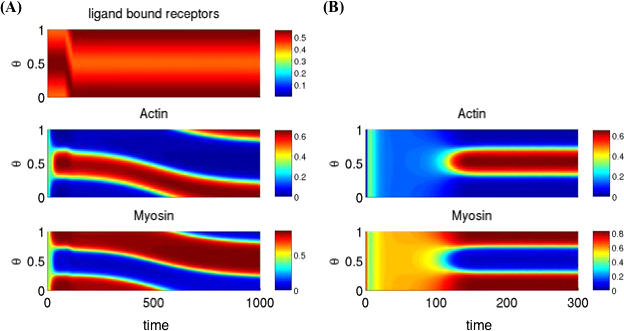
Alternative Model of Gradient Sensing and Spontaneous Polarization(A) Spatial and temporal distribution of ligand-bound receptors, actin, and myosin in response to a 50% gradient of chemoattractant. Gradient direction rotates by 180° from t = 80 − 120s.(B) Spontaneous polarization in response to a uniform stimulation (bL = 1) with a perturbation of size 0.1 made to the receptor–ligand complex at θ = 0.5. Note that myosin localizes at the site of the perturbation. This behavior is opposite that of the original model.